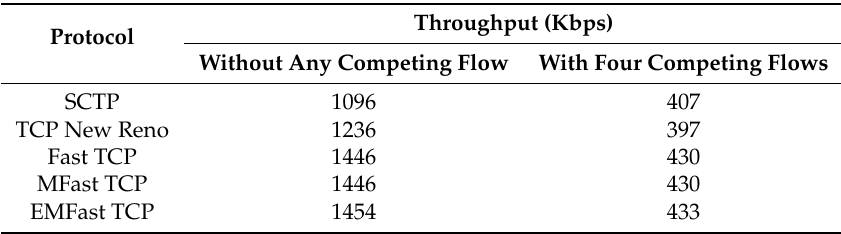
Table 2. End-to-end throughput of the protocols (average for five tests) [Table S2].